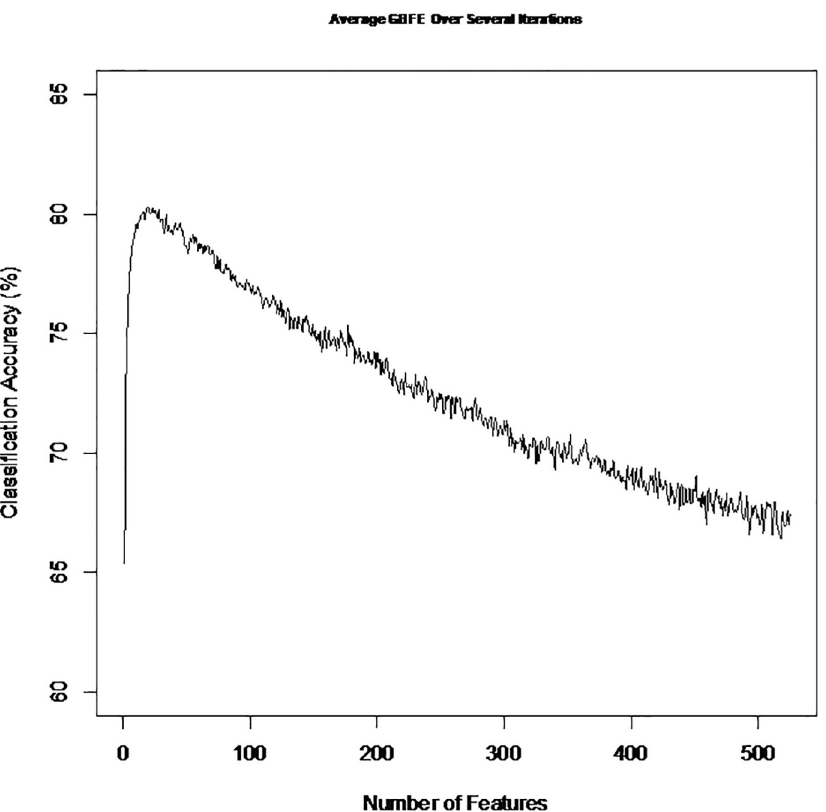
Fig 4. Accuracies obtained using a leave tenth out cross validation (LTOCV) to predict bacterial protective antigens (BPAs) or non-BPAs from the dataset BPAD200. Features were eliminated using a greedy backward feature elimination procedure. Black line depicts 10 feature cut off that was implemented in this study as it was shown for the dataset BPAD200 to best separate signal from noise[16].